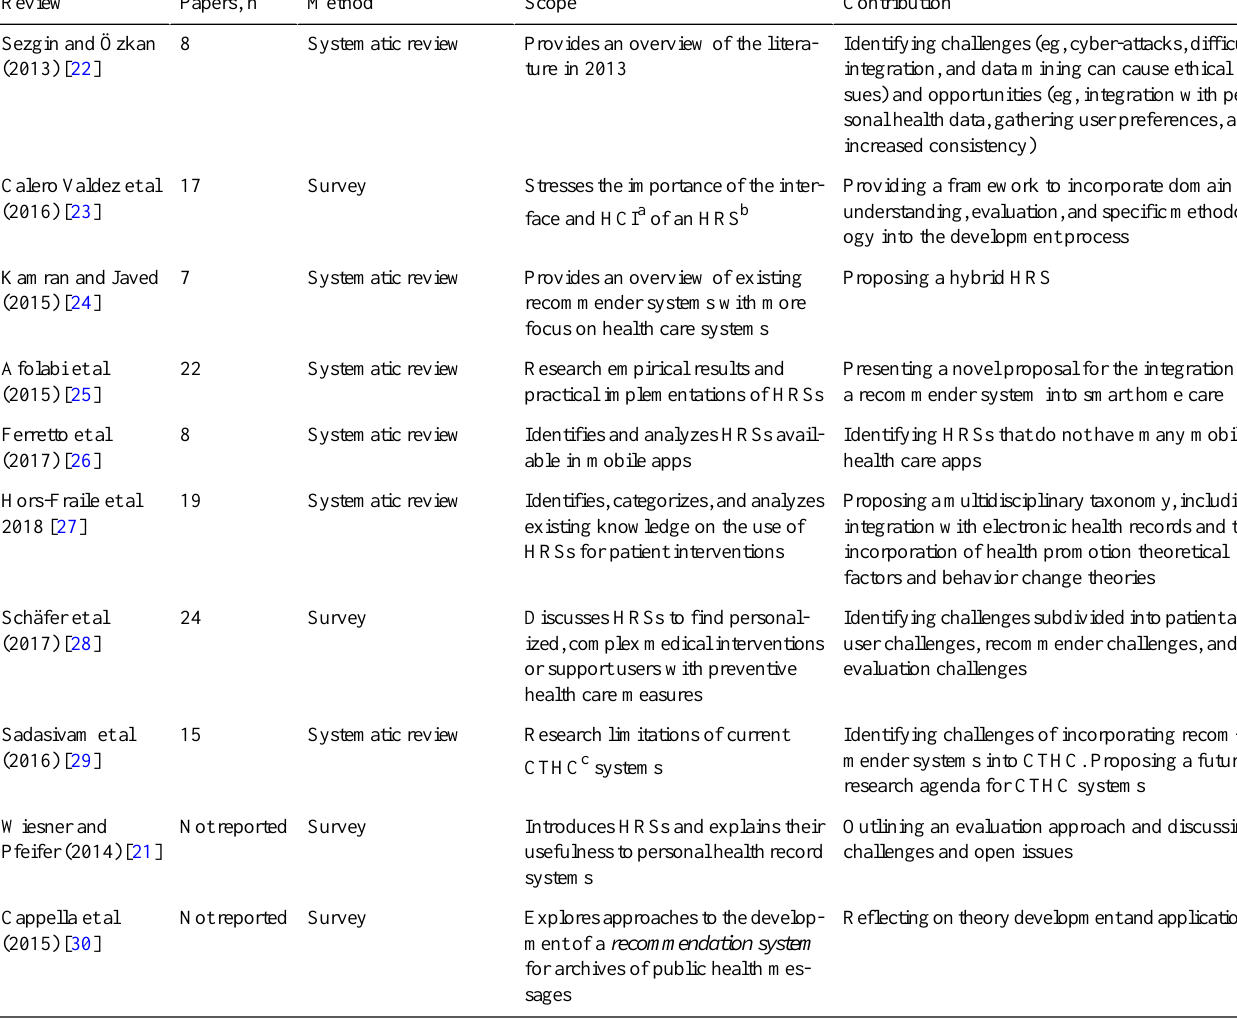
Table 1. An overview of the existing health recommender system overview papers. ContributionScopeMethodPapers,